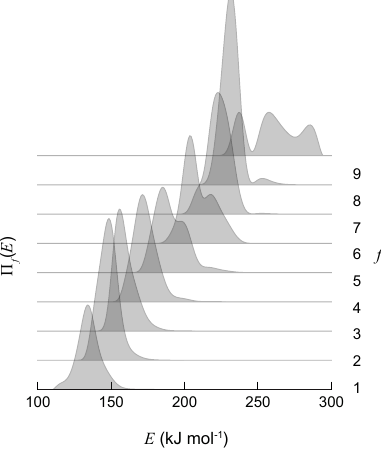
Figure 8. (cid:53) f (E) distributions for Narayani POC ( f = 1 ,..., 9). Each (cid:53) f (E) represents the range of E values contained within RPO fraction f . The sum of all (cid:53) f (E) distributions shown here thus yields the p( 0 ,E) distribution shown in Fig. 7. Distributions have been staggered along the y axis for visual clarity. (cid:53) f (E) dis- tributions do not follow any predictable functional form and are highly overlapping due to the fact that OC associated with a given E value decays over a wide time interval (Cramer,